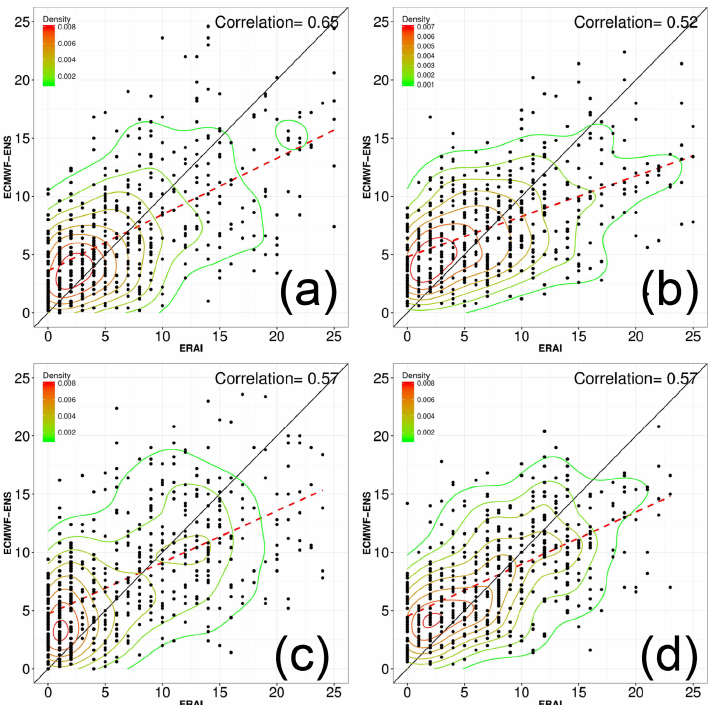
Figure 7. Scatter plots of the occurrence of the four winter WRs provided by ERAI ( x axis) and provided by ENS ( y axis). The linear least-square regressions are indicated with red dashed lines and the corresponding correlation on the top right of each